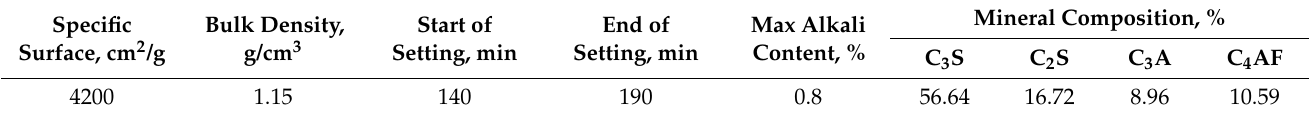
Table 1. Main characteristics of OPC.